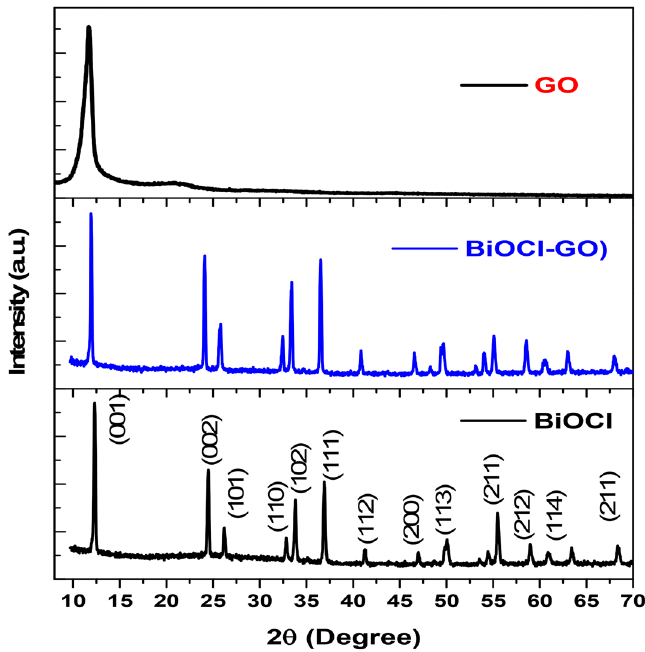
Figure 1. XRD pattern of GO, BiOCl and BiOCl–GO .